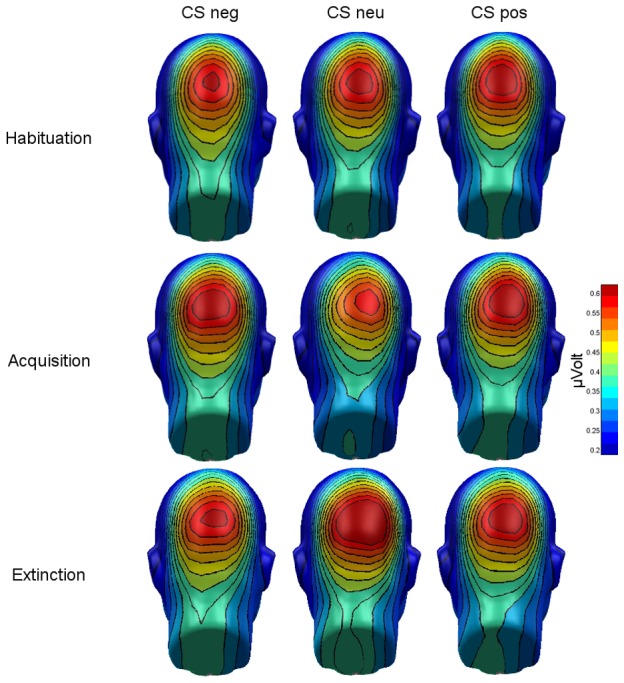
Mean scalp topographies of ssVEP amplitudes (100–4,900 ms) elicited by CSneg, CSneu, and CSpos faces in during the three phases of the experiment (habituation, acquisition, extinction).